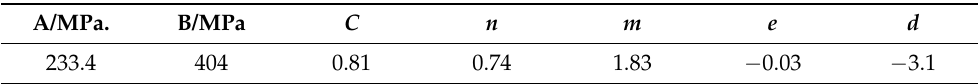
Figure 7. Improved σ y − ln ˙ ε ∗ fitting relationship. Figure 7. Improved 𝜎 𝑦 − 𝑙𝑛𝜀̇ ∗ fitting relationship. Table 5. Parameters of J-C model after optimization. Table 5. Parameters of J-C model after optimization.